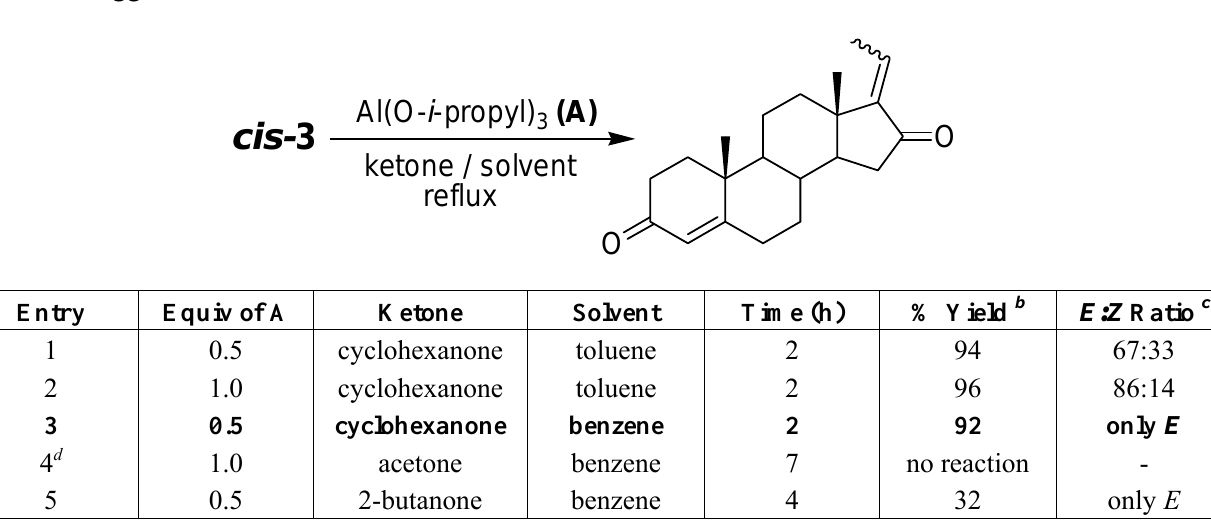
Table 1. Optimization of Oppenhauer Oxidation Conditions for the Synthesis of E -Guggulsterone.